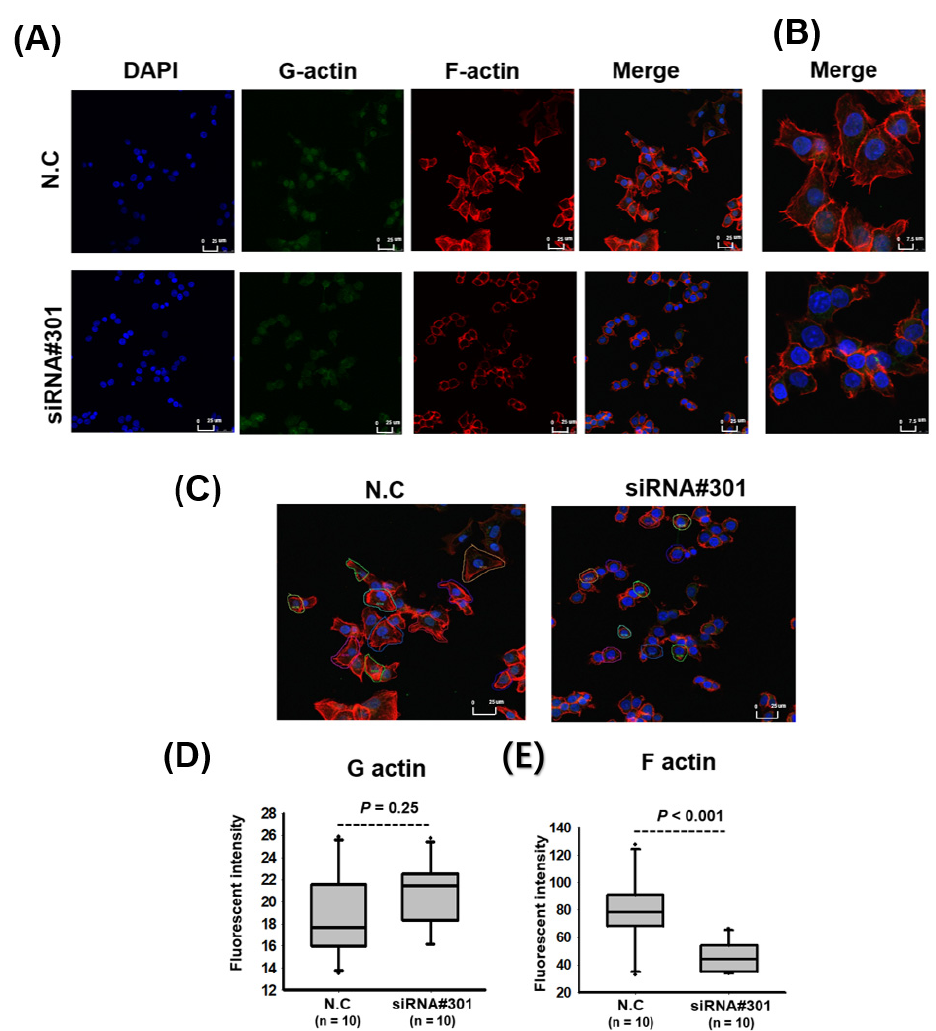
Figure 6. LOC550643 knockdown modulated G-actin and F-actin polymerization to inhibit colon cancer cell motility. ( A ) After LOC550643 knockdown, F-actin and G-actin were stained with rhodamine phalloidin and Alexa Fluor 488, respectively. The fluorescence intensity of HCT116 cells was determined through confocal microscopy (magnification 40×). ( B ) Images of F-actin (red), G-actin (green), and nuclei (blue) were merged, revealing that HCT116 cells with LOC550643 knockdown exhibited fewer filopodium fibers than did normal HCT116 cells (magnification 100×). ( C – E ) Fluorescence intensities of G-actin and F-actin were calculated through confocal microscopy ( n = 10). 3.5. miR-29b-2-5p Inhibited LOC550643 Expression by Directly Binding at Its Sequence High LOC550643 expression in CRC tissues was strongly associated with poor pa- tient prognosis. However, the mechanisms underlying abnormal LOC550643 expression and LOC550643 knockdown–induced inhibition of the growth and invasion abilities of CRC cells remain unclear. Assessing the expression of LOC550643 revealed that LOC550643 was mainly accumulated in the cytoplasm of the CRC cells (Supplementary Figure S5). Therefore, we postulated that LOC550643 modulated cell growth and motility by sponging miRNAs expression. We further determined which miRNAs could bind to the LOC550643 sequence by using microRNA prediction tool. We selected miR-29b-2-5p because it was expected to bind to the LOC550643 sequence. Examination of miR-29b-2- 5p expression in CRC cells through an analysis of the TCGA database demonstrated that miR-29b-2-5p was significantly reduced in cancer tissue samples compared with in the histologically normal tissue samples (Figure 7A). Furthermore, the Pearson correlation